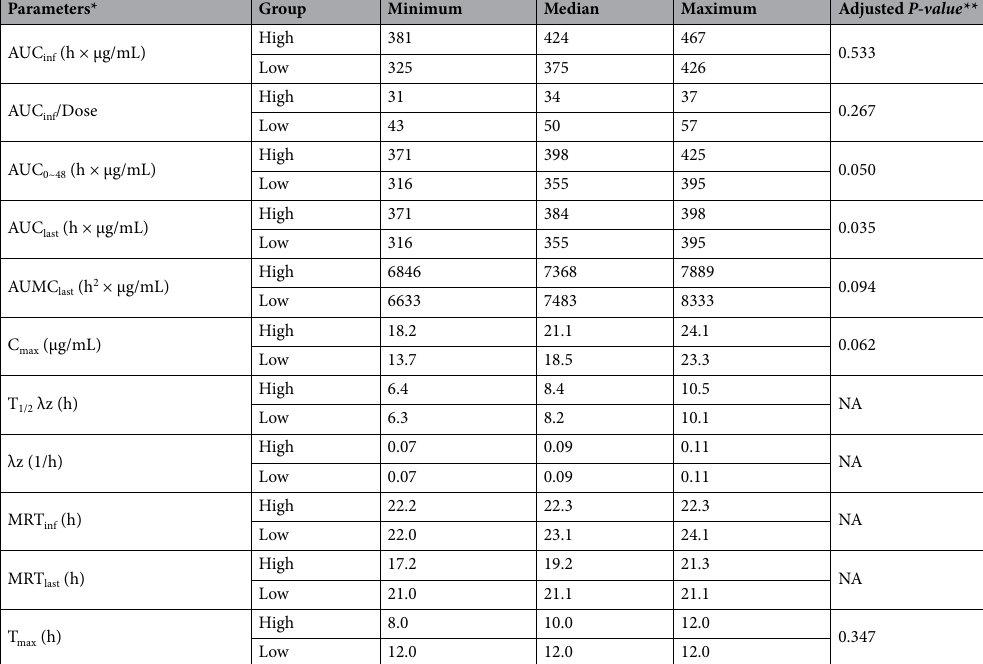
Table 6. The fecal pharmacokinetics of ciprofloxacin in calves administered enrofloxacin subcutaneously (low dose 7.5 mg/kg, high dose 12.5 mg/kg body weight, 14 animals in each healthy and BRD combined group) computed by a non-compartmental model (i.e., statistical moments) analysis. * PK-parameters area under the curve from the time of dosing extrapolated to infinity (AUC inf ), area under the curve from the time of dosing to the last sampling time point (AUC 0~48 ), area under the curve from the time of dosing to the last measurable positive concentration (AUC last ), area under the first moment curve from dosing to the last measurable concentration (AUMC last ), maximum observed concentration (C max ), mean residence time from the time of dosing to the last measurable concentration (MRT last ), time to the maximum concentration (T max ), terminal half-life (T 1/2 λz), and elimination rate (λz). Groups control—healthy control calves, and BRD— M. haemolytica infected calves. NA not applicable. **Mann–Whitney test was used to compare the high and low dose